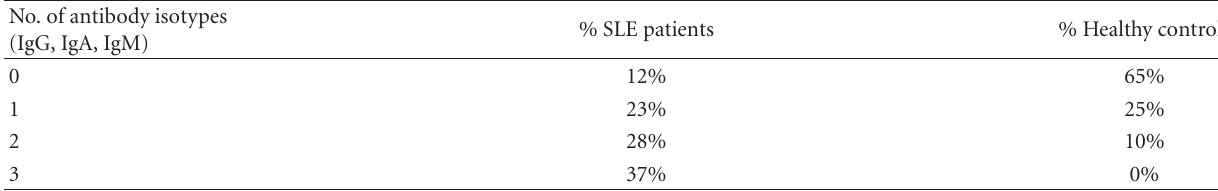
Table 2: EBV-EA/D antibodies in SLE patients and healthy controls